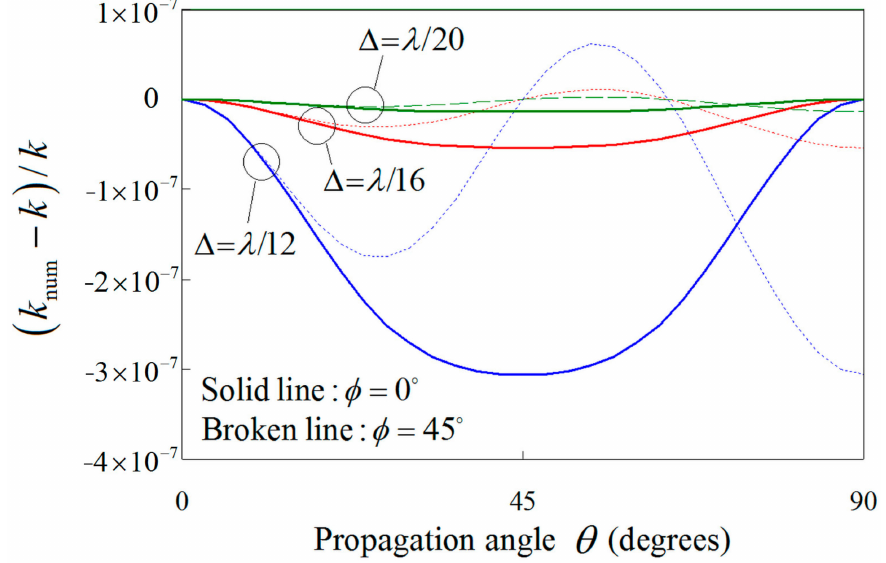
Figure 8. Propagation error of the numerical wavenumber, k num , for the NS-FDTD method combined with the proposed PI model. Note that ∆ is the grid size, k the physical wavenumber, λ the wavelength, and φ , θ the angles of the spherical coordinate system ( r , φ , θ ) . The PI model attains a high propagation accuracy, practically equivalent to that of the NS-FDTD method along the axial direction φ = 0 ◦